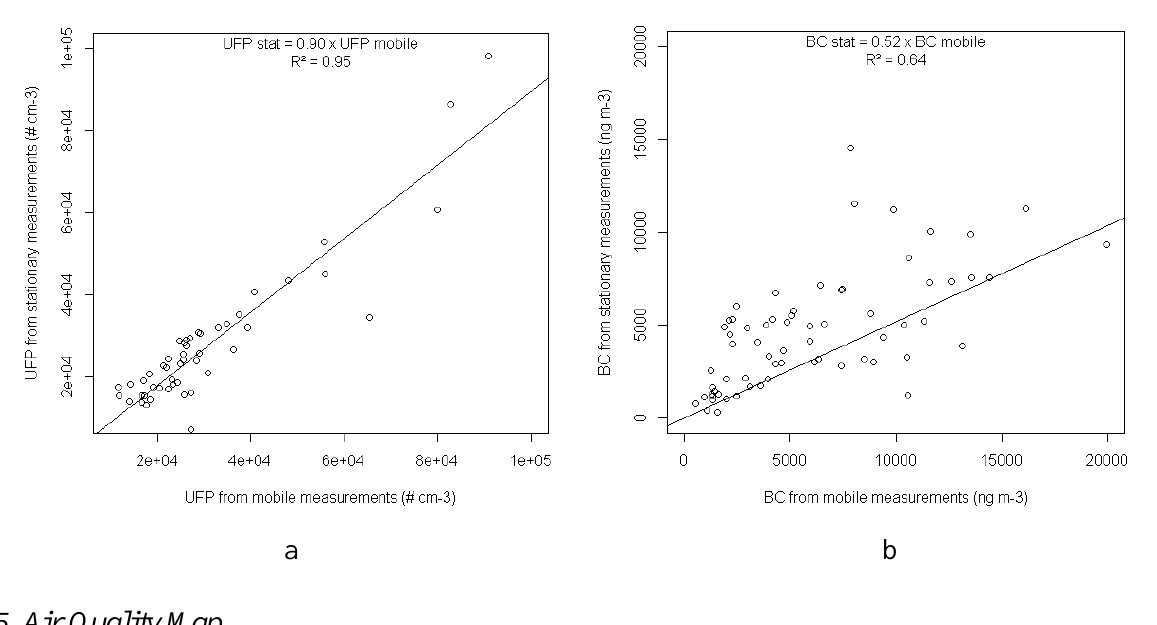
Figure 10. Scatterplots of mobile versus stationary UFP ( a ) and BC ( b ) measurements. Linear regressions are fitted to the data.